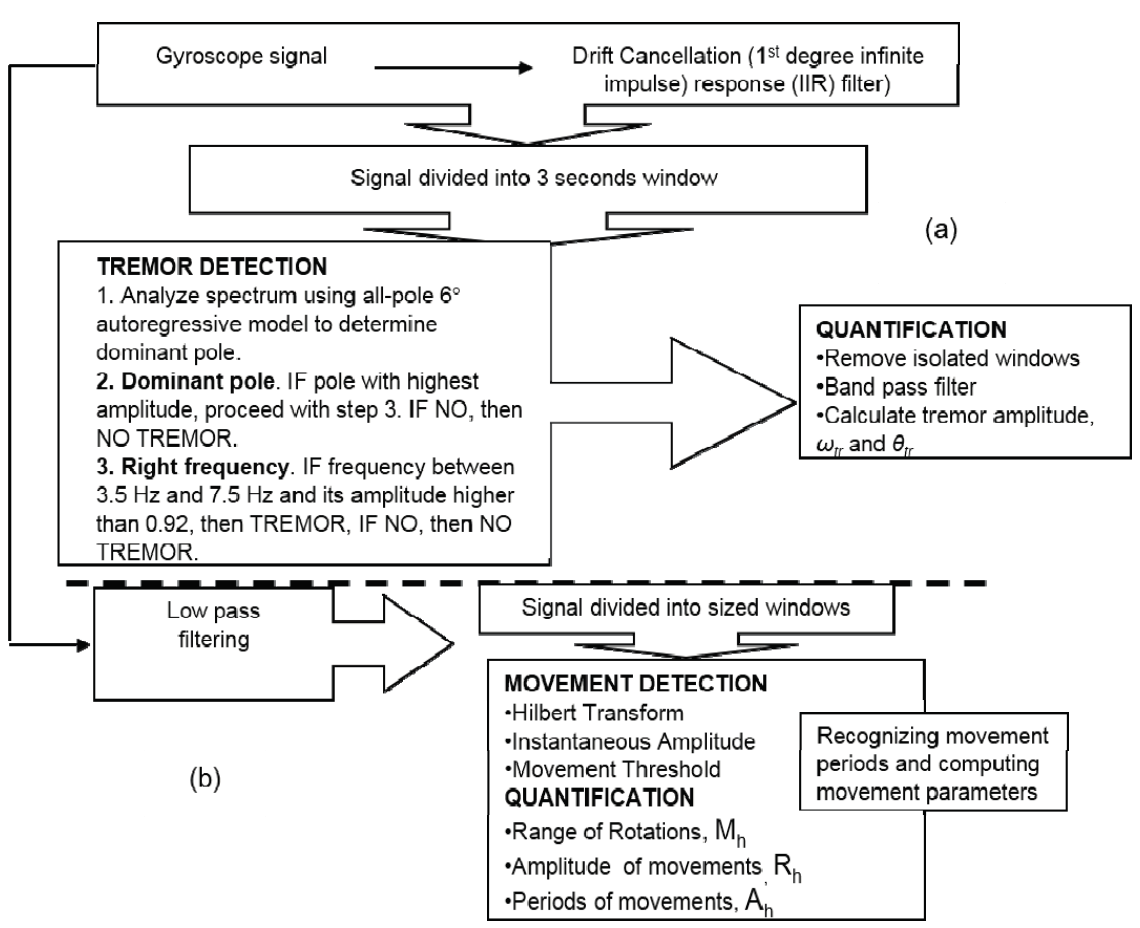
Figure 6. Flowcharts of the techniques. ( a ) Detection and quantification techniques for tremor; ( b ) Techniques for bradykinesia